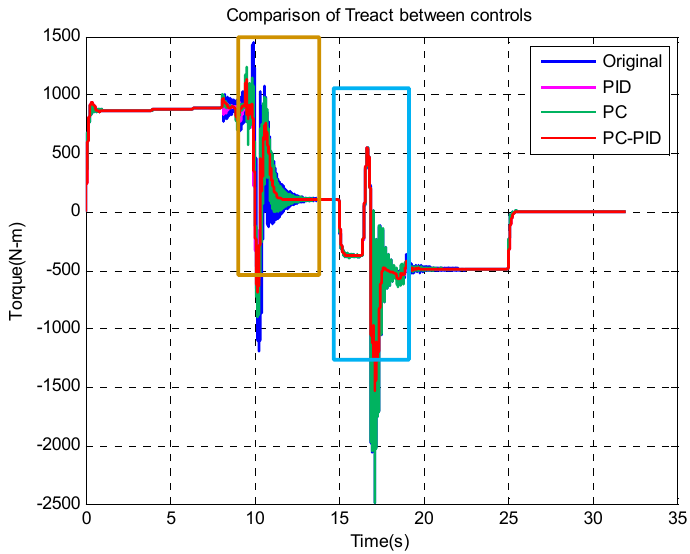
Figure 7. Half-shaft torque comparison with different control methods in time domain.